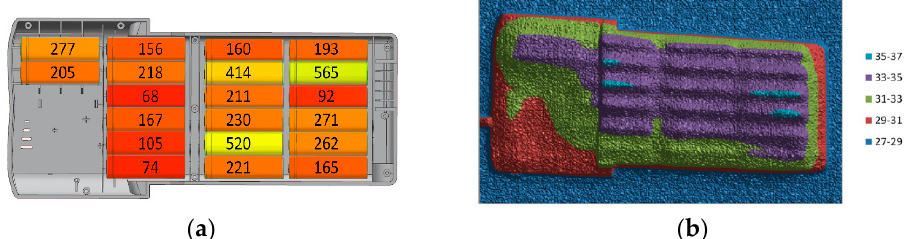
Figure 22. Comparison of ( a ) BOT layer capacity distribution in (mAh) and ( b ) measured temperature values in (°C).